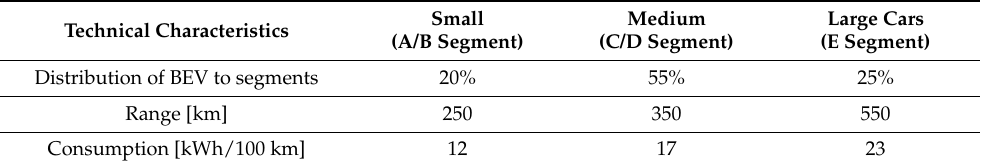
Table 4. Vehicle characteristics used in all simulation runs.